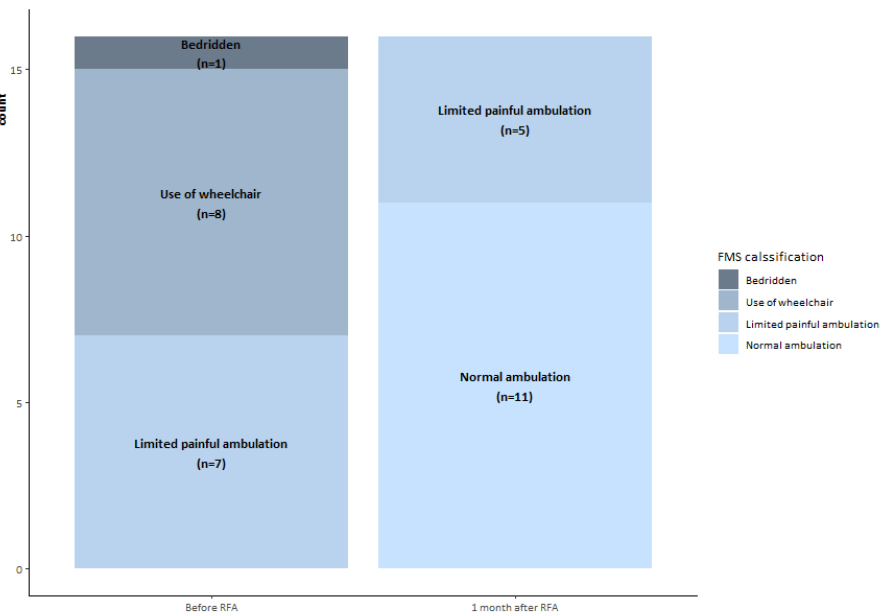
Figure 6. Functional Mobility Scale (FMS) classification patients rated before and 1 month after the interventional treatment. interventional treatment.